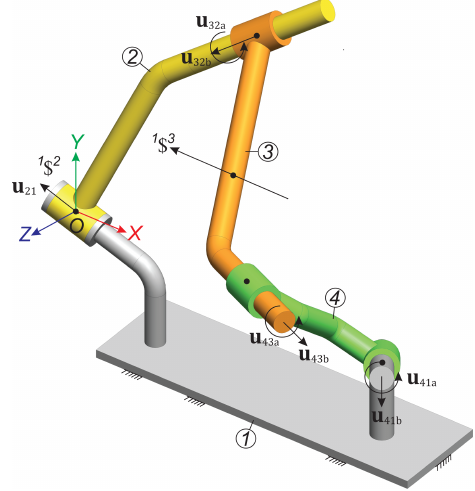
Figure 6. The RCCC spatial